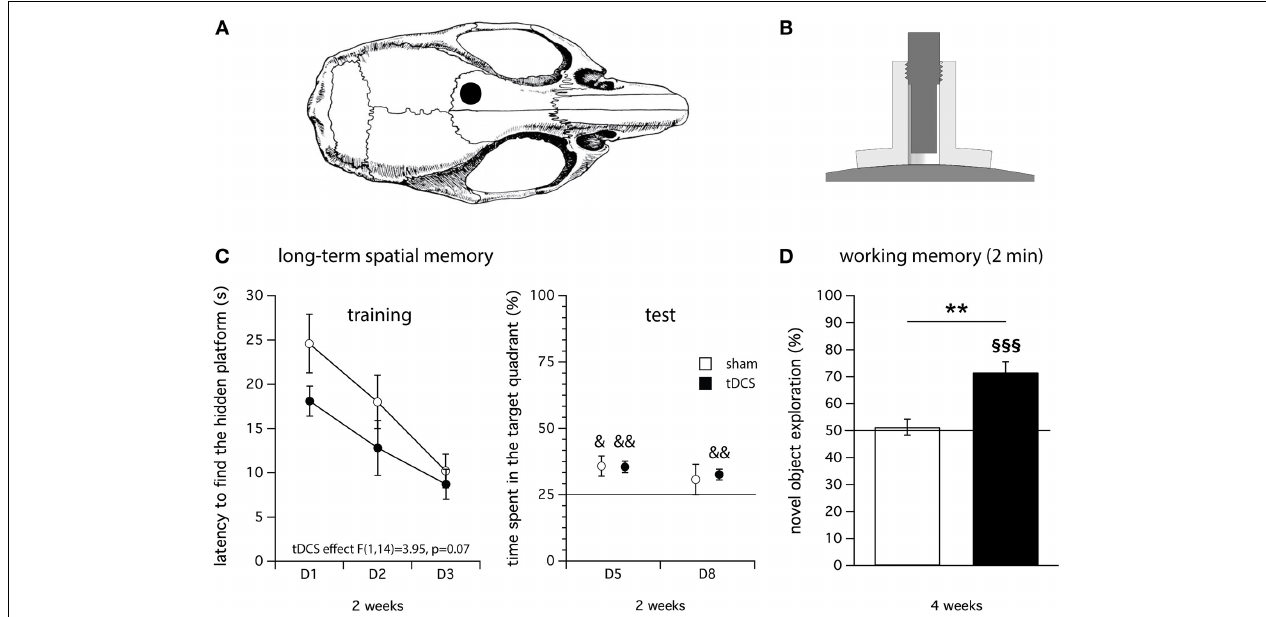
FIGURE 1 | Illustration of the tDCS device used to deliver the electrical stimulation in mice (Pedron et al., 2014) and main results obtained on cognition. (A) The center of the stimulation electrode (anode) is positioned over the left frontal cortex 1mm anterior to the coronal fissure and 1mm left of the sagittal fissure (Paxinos and Franklin, 2001). The cathode (rubber-plate electrode, 9.5cm 2 ) is placed onto the ventral thorax (not shown). (B) Anode: A tubular plastic jacket (internal diameter: 2.1mm) is surgically fixed onto the skull and filled with saline solution before the stimulation. The stimulation electrode is screwed into the tubular plastic jacket and immersed in the saline solution. Only the saline solution is in contact with the skull. (C) Four month-old Swiss female mice were